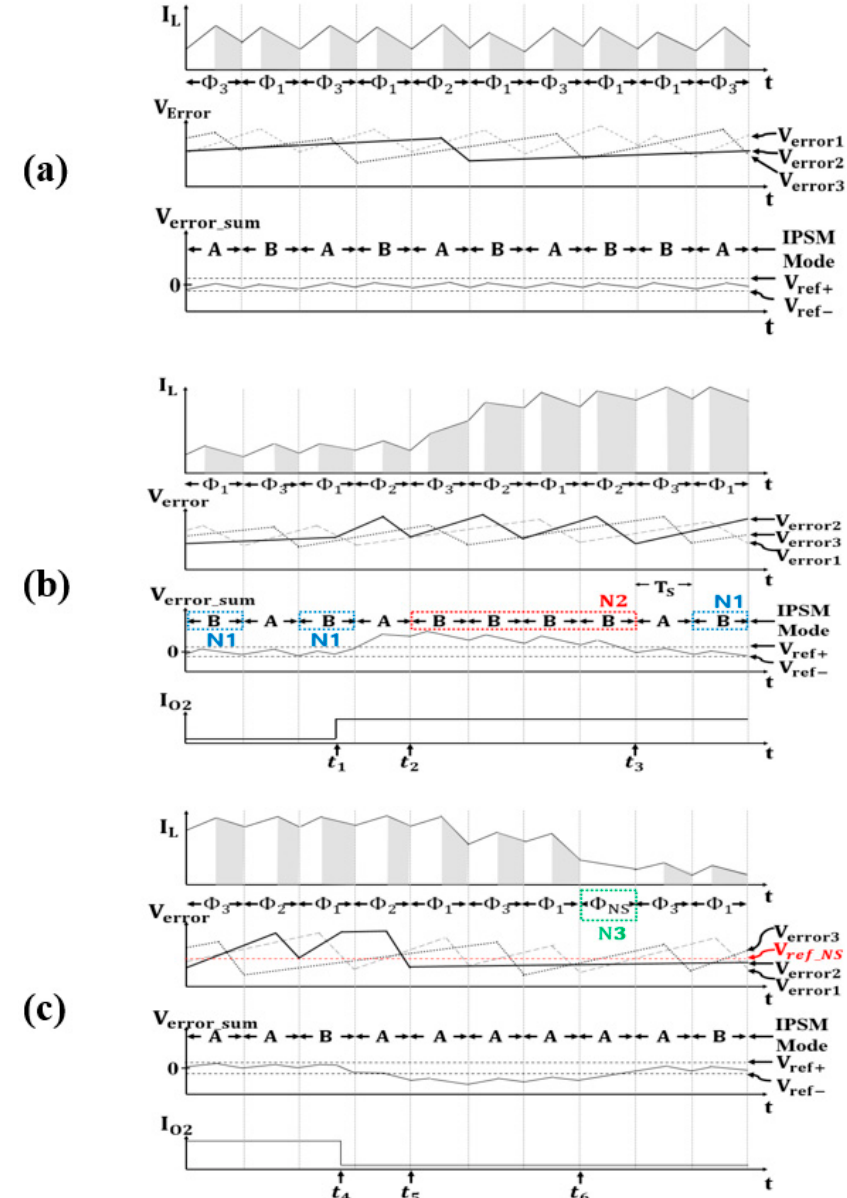
Figure 4. Illustrated transient waveforms of the proposed EDRC scheme under ( a ) steady state, ( b ) a positive step change and ( c ) a negative step change of load current in output 2. We presume that output 1 is of the deep boost type (V O (cid:29) V g ). The IPSM B indicated by N1 mark is assigned for supplying the deep boost output, the IPSM B indicated by N2 is assigned for increasing the inductor current level, and the Φ NS indicated by N3 mark is the inductor current freewheeling phase where no output is